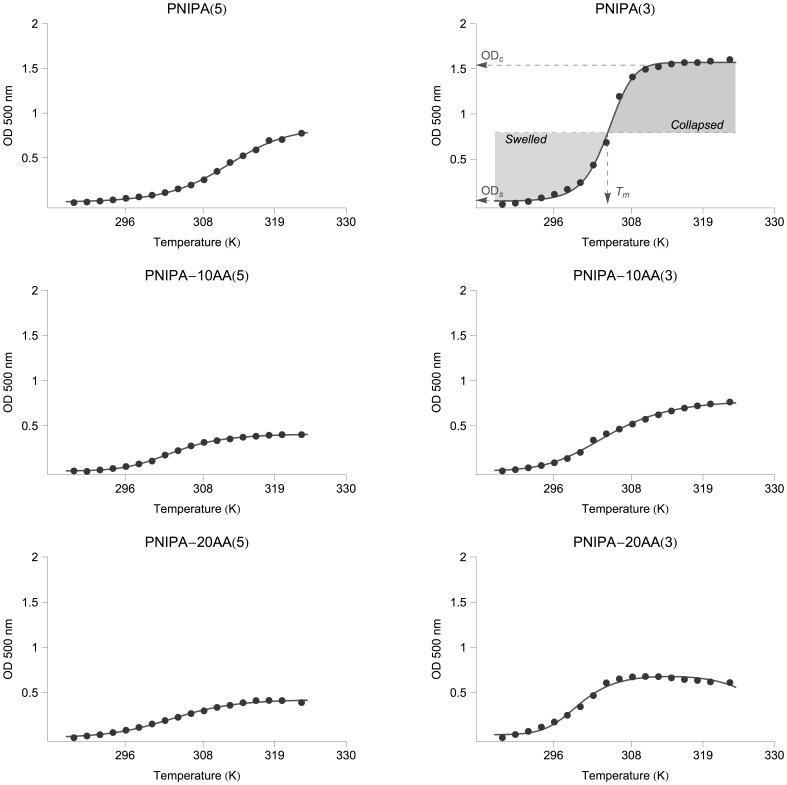
Optical density (OD) variation of PNIPA/AA nanohydrogel as a function of temperature (K).Nanohydrogels synthesized with 3% and 5% of cross-linking degree (CL) were previously swelled in distilled water (12.5 mg mL−1) at 25°C. The lines are the fitting curves generated from Equation 13. The meaning of the most relevant parameters for defining a collapse curve of a PNIPA nanohydrogel exposed to increasing temperatures is graphically illustrated in the subfigure PNIPA(3): Tm represents the lower critical solution temperature (LCST), ODs and ODc are the characteristic optical density values in the swelled state and the collapsed state, respectively.”